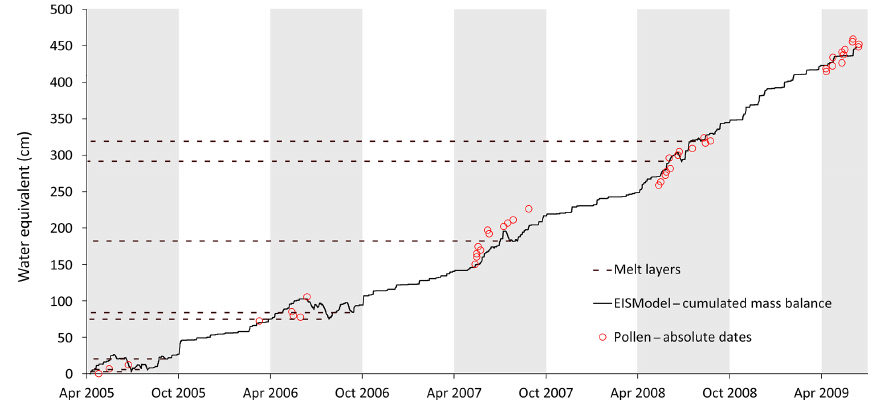
Figure 4. Comparison between cumulated mass balance modeled by EISModel and obtained by pollen dating. Alternating grey/white bars have a 6-month duration and roughly indicate the warm/cold season. Horizontal dash lines indicate melt